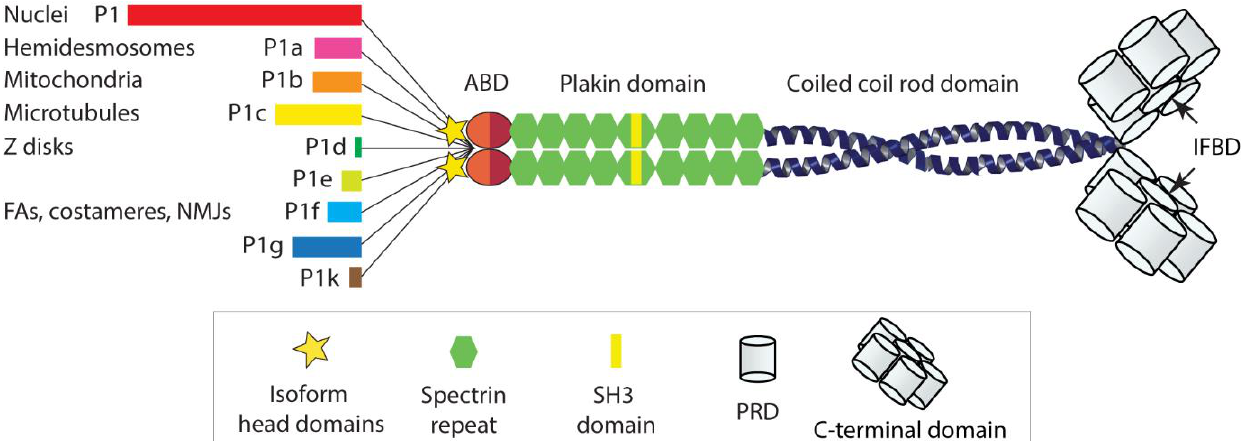
Figure 1. Schematic representation of a plectin dimer. The N -terminal domain contains two actin-binding domains (ABDs) each consisting of two calponin homology domains (light and dark red), and two plakin domains each comprising nine spectrin repeats (green) and one (noncanonical) SH3 domain (yellow). The central coiled-coil rod domain is ~200 nm long. The C -terminal domains each contain six plectin repeat domains (PRDs), where PRDs consist of a conserved region, referred to as module, and a linker region, one of which harbors the universal IF-binding domain (IFBD). The stars at the N termini of the polypeptide chains stand for the different isoform-specific head domains. Nine alternative head domains are depicted (color-coded bars), giving the name to plectin isoforms P1, P1a, P1b, etc. Major isoform targeting sites are indicated. Note: the figure is not drawn to scale, while the length of the bars is proportional to the size of the head domains.